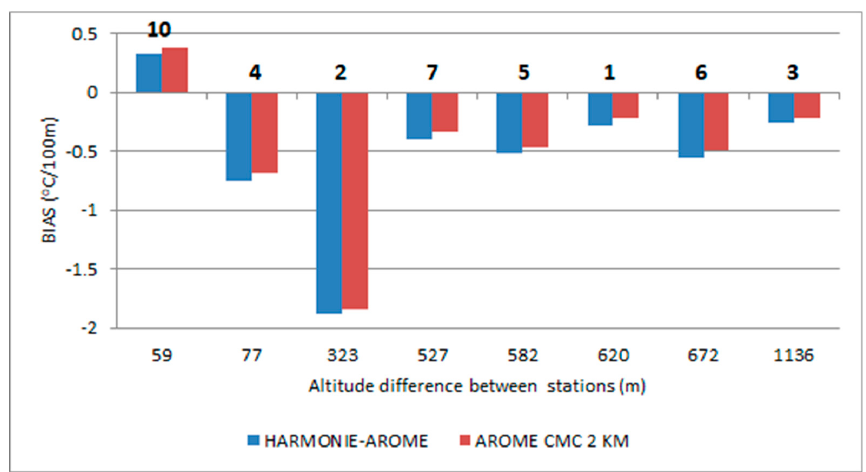
Figure 14. Bias values for predicted temperature gradients for HARMONIE ‐ AROME and AROME CMC 2 km.